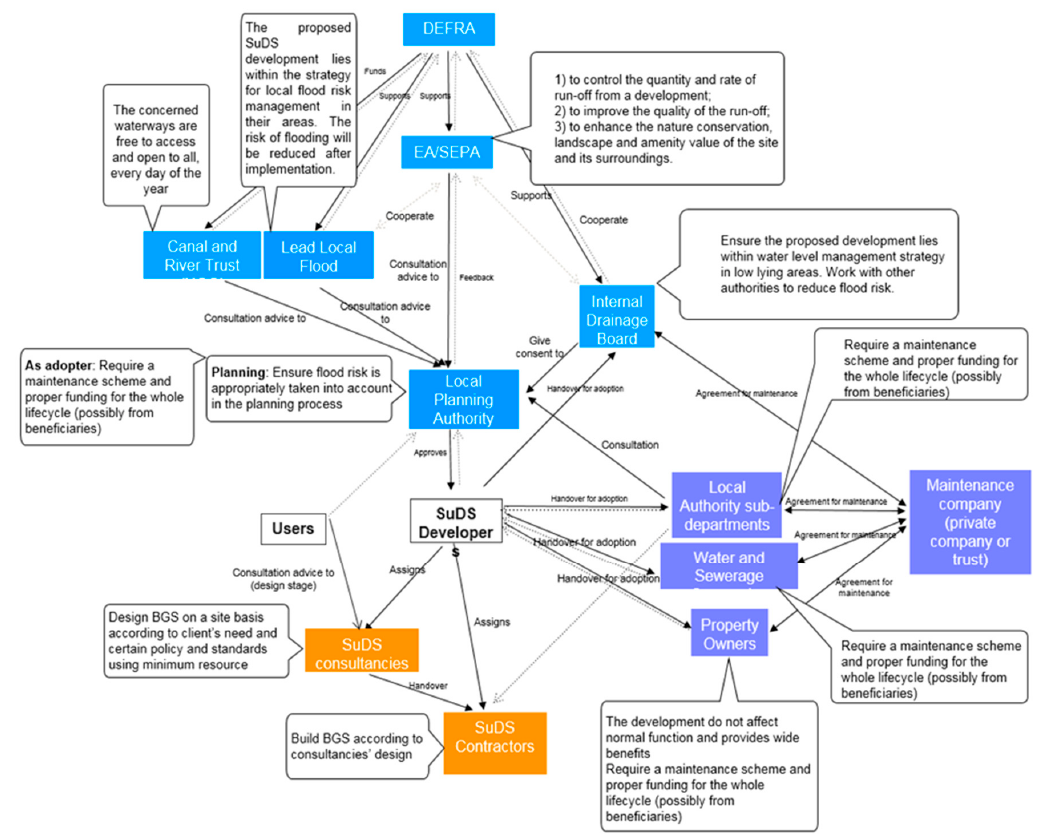
Figure 4. Stakeholders system map for the UK SuDS system (blue colour for the Institutional group, orange colour for the Design and Build group, purple colour for the Adoption and Maintenance group; dotted arrows represent a feedback link). DEFRA, Department for Environment, Food and Rural Affairs; EA, Environment Agency; SEPA, Scottish Environment Protection Agency; BGS, Blue Green Solution.